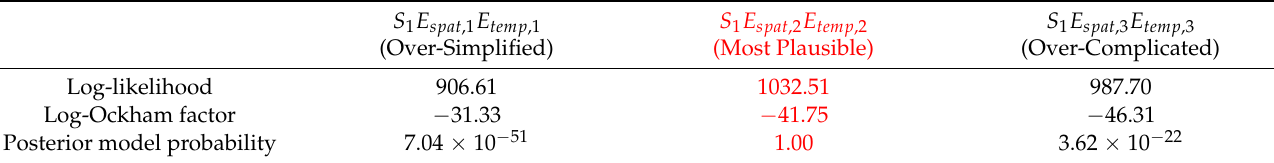
Table 4. Model class selection results (damaged case).